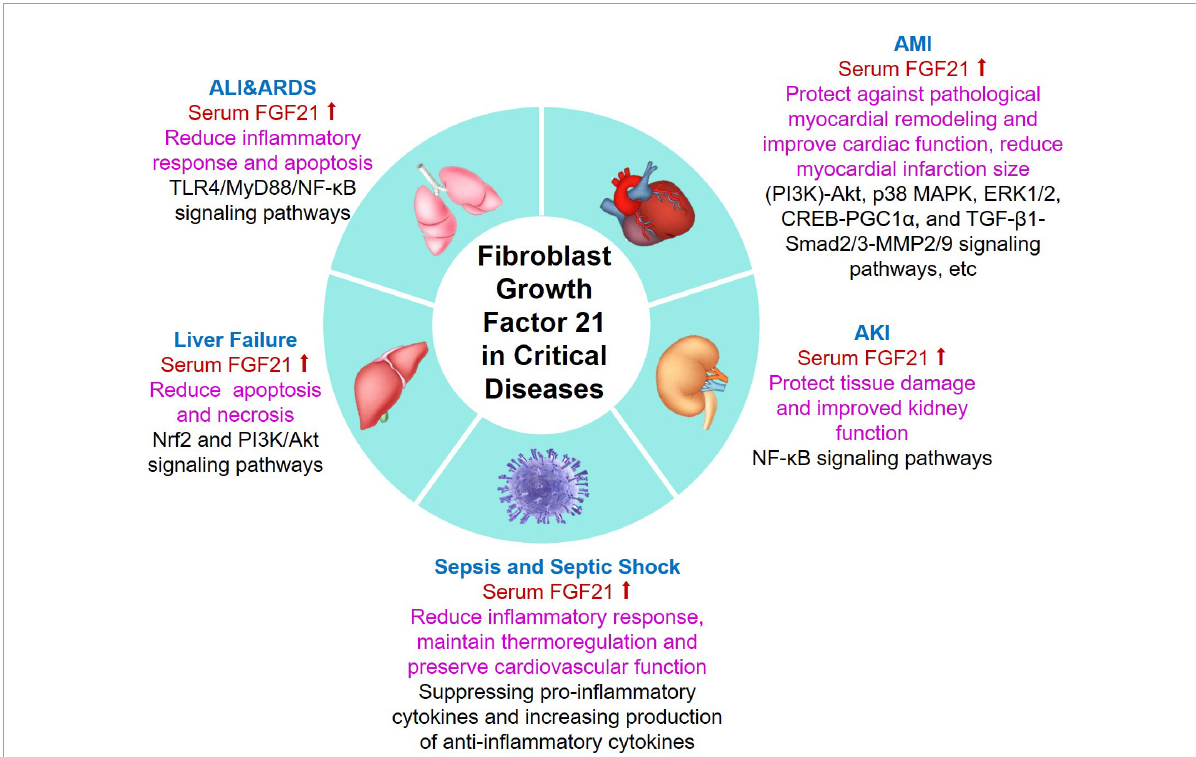
FIGURE2 Summary of emerging roles and related mechanisms of FGF21 in critical diseases. Serum FGF21 levels were increased in patients with critical diseases including ALI/ARDS, AMI, AKI, sepsis, and liver failure. Additionally, FGF21 plays different biological functions in critical patients with different underlying mechanisms. ALI, acute lung injury; ARDS, acute respiratory distress syndrome; AMI, acute myocardial injury; AKI, acute kidney injury; FGF21, fibroblast growth factor